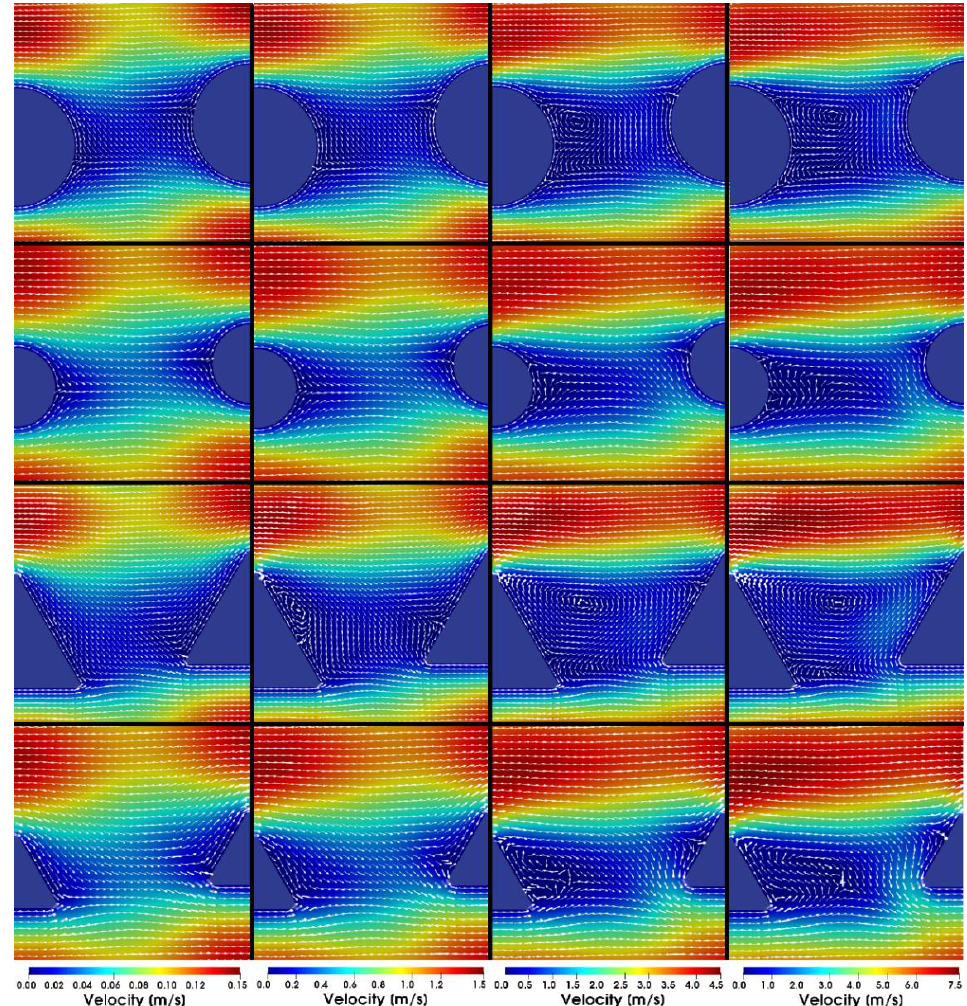
Figure 8. The pictures show the vector fields in the flow wake behind the circular and triangular posts with an H / G of 1 and 0.5 for the Reynolds numbers 1, 10, 30 and 50 shown from left to right. In the case of triangular posts, vortices occur at lower Reynolds numbers and become significantly larger. Color scales refer to the velocity magnitude.